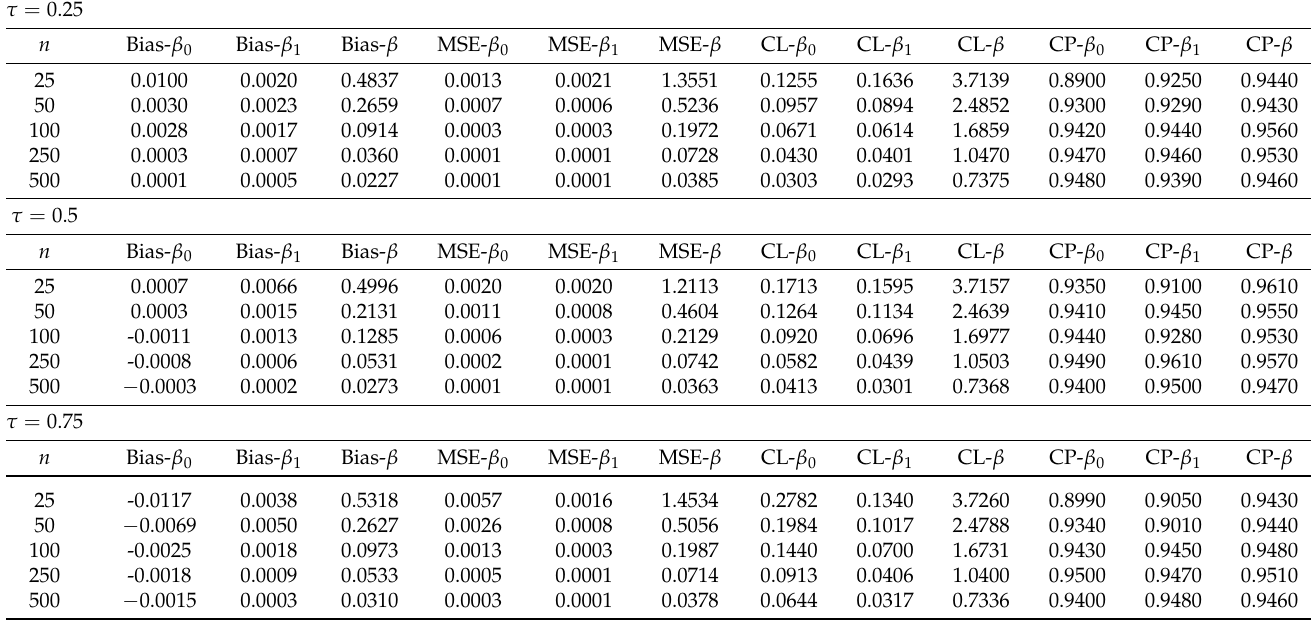
Table 1. The empirical biases, MSE, 95% CP, and 95% CL for the QLEP regression model with τ = 0.25,0.50 and